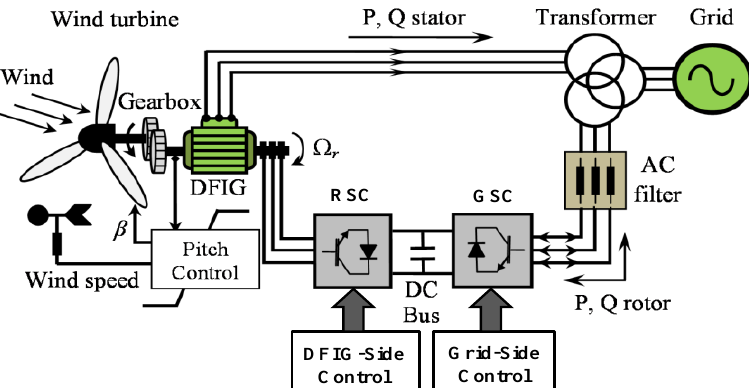
DFIG-Side Figure 1. Wind energy conversion system based a DFIG